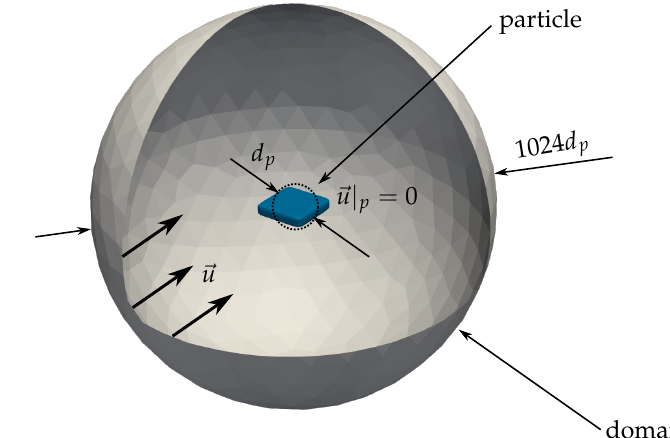
Figure 2. Numerical domain in the shape of a sphere, with the diameter of the 1024 d p . The particle under consideration is positioned in the centre of the domain, with its volume equivalent diameter d p . The boundary condition, on the surface of the outer sphere is a constant velocity field (cid:126) u , while a no slip condition (cid:126) u | p = 0 is imposed on the particle